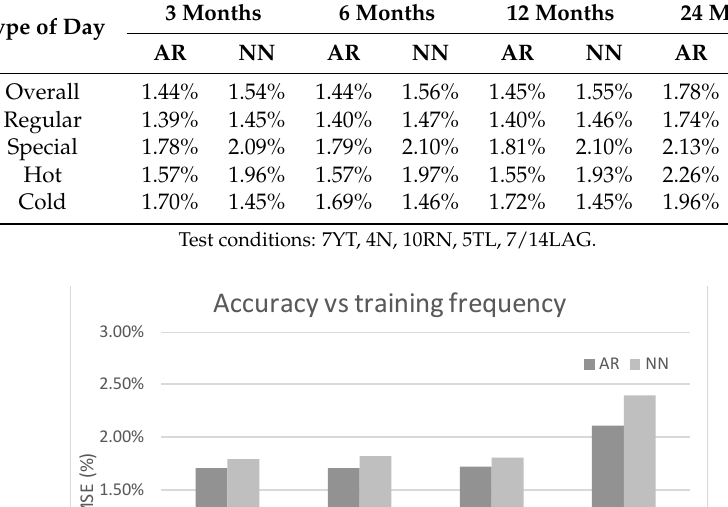
Table 7. Forecasting error (RMSE) with different training frequency.